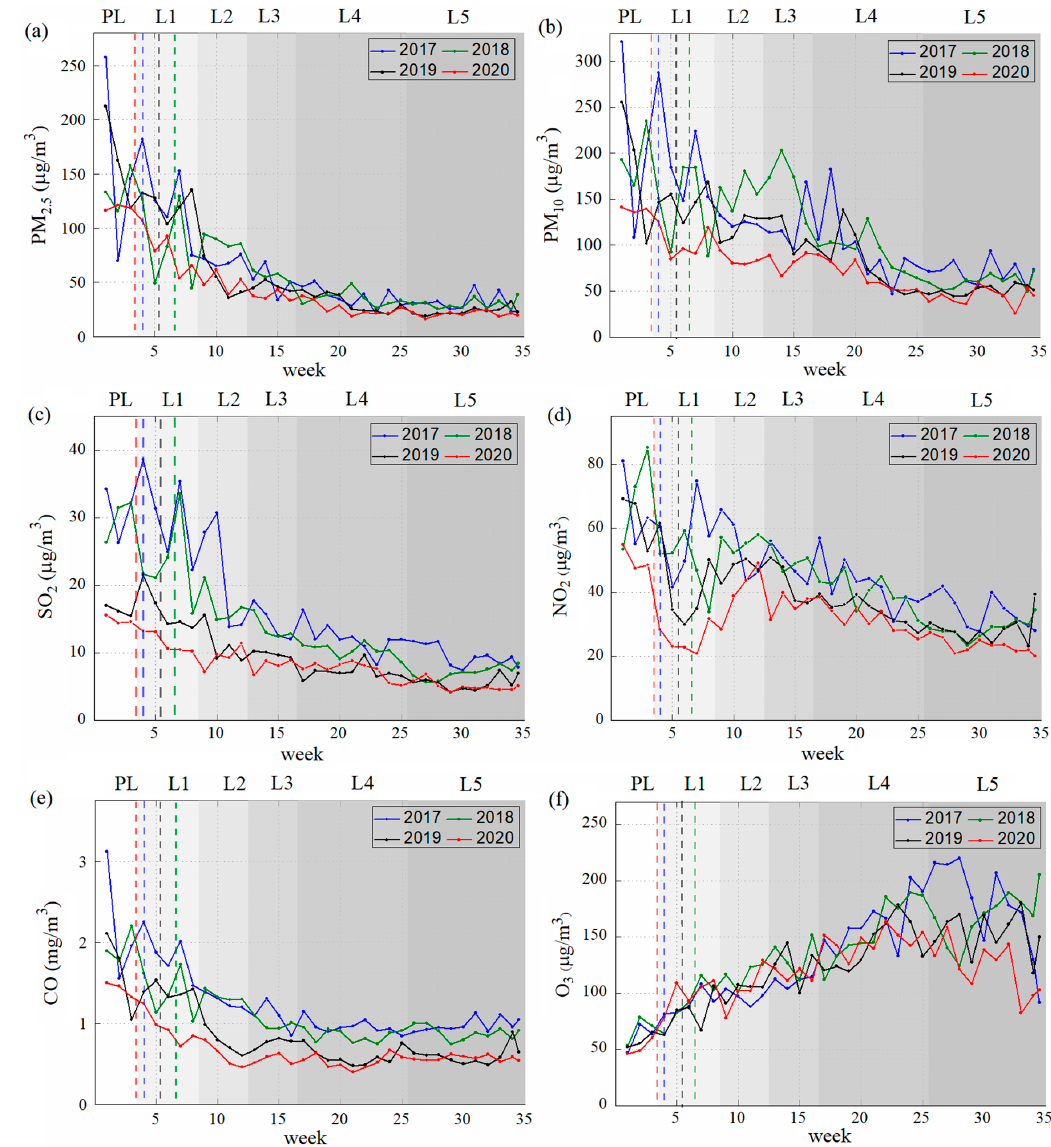
Figure 4. Time series of weekly mean concentrations of PM 2.5 ( a ), PM 10 ( b ), SO 2 ( c ), NO 2 ( d ), CO ( e ) and O 3 ( f ) averaged over all measurements at the monitoring stations in the Guanzhong Basin during the first 35 weeks for six stages (Pre-lockdown, PL; Level-1, L1; Level-2, L2; Level-3, L3; Level-4, L4; Level-5, L5) in the years 2017–2020. The circles represent the weekly mean concentrations and the colors indicate the different years (see legend). The vertical colored dashed lines indicate the dates of the Chinese Spring Festival (Lunar New Year) of the different years. The four stages are indicated with different grey shading. Note the different vertical scales for each species.